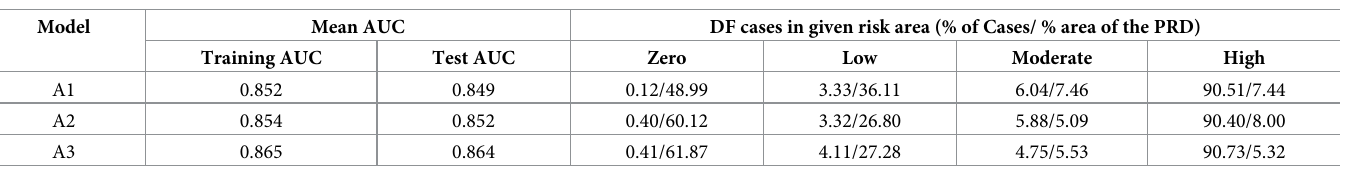
Fig 3. The spatial distribution of different socioeconomic variables in 2015, 2050 and 2070. (a) LULC, (b) GDP, and (c) population density. https://www.resdc.cn/data. aspx?DATAID=201. https://doi.org/10.1371/journal.pntd.0009745.g003 Table 2. Model validation results of the current